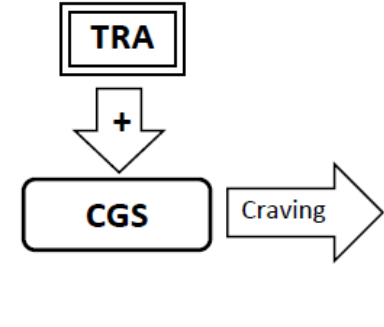
Figure 10. With the Abstinence-Related Adaptations (ARA) gone, when the down-stream effects of nicotine wear off, the Tolerance-Related Adaptations (TRA) provide un-opposed stimulation to the Craving Generation System (CGS) and this restores craving to its original intensity. Because the Tolerance-Related Adaptations set the latency to the onset of withdrawal craving, relapsed smokers find that they need to smoke at nearly the same frequency as when they had quit smoking no matter how long they had been